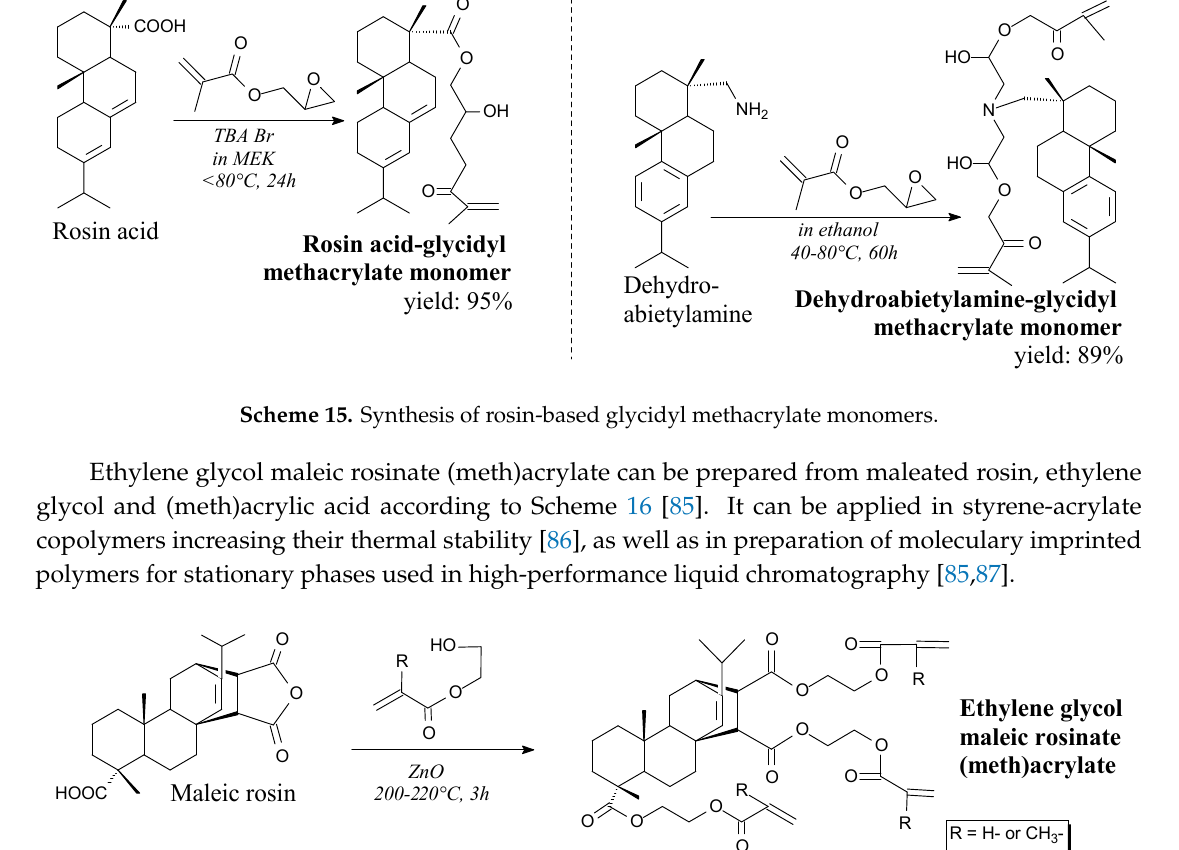
Scheme 14. Synthesis of rosin-based high adhesion polyurethane acrylate.